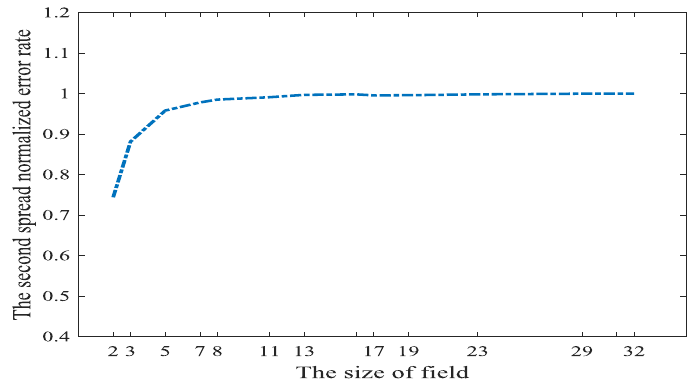
Figure 8. The spread of errors in non-coherent networks on field size. The blue line is the function of spread normalized error rate based on the size of field.